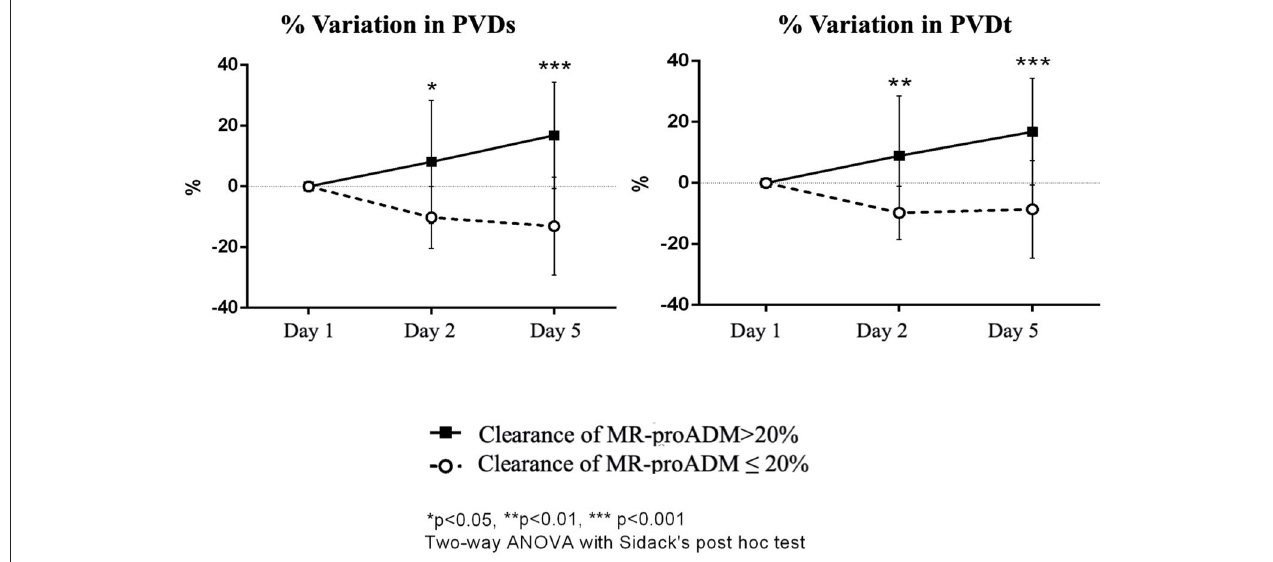
FIGURE 4 | Percentual variation of perfused vessel density of small vessels (PVDs) and PVD of total vessels (PVDt) from baseline in the two groups of patients (clearance of MR-proADM inferior-to-equal or higher than 20%). The two-way ANOVA with the Sidack’s post-hoc test. * p < 0.05. ** p < 0.01. *** p < 0.001.